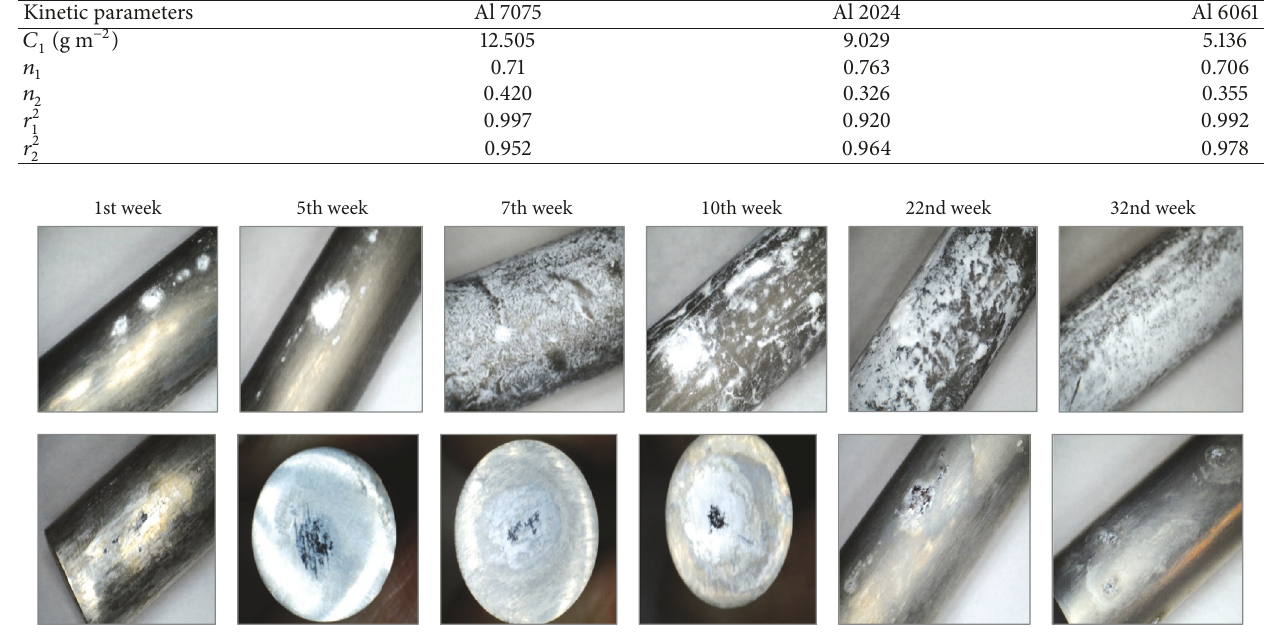
Figure 3: Visual images of Al 7075 specimens after immersion in the Red Sea water at different time intervals.